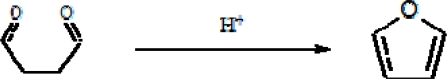
Paal-Knorr synthesis of C4H4O.